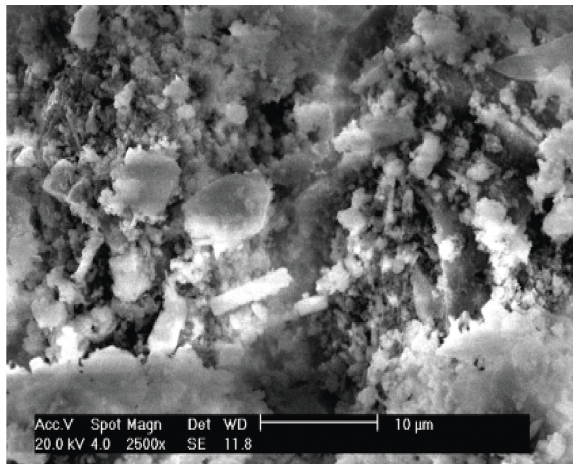
Figure 7: SEM micrograph of BNLA powder